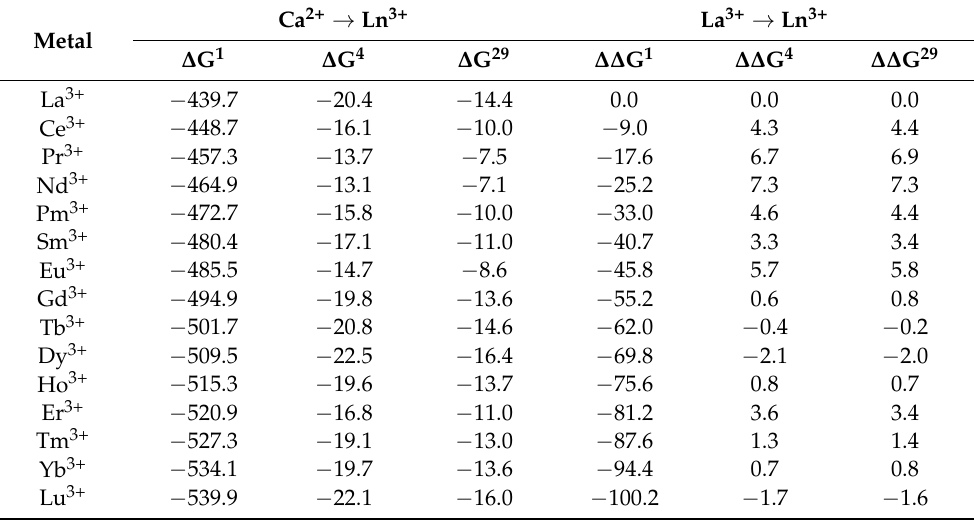
Table 2. Free energies of the Ca 2+ → Ln 3+ and La 3+ → Ln 3+ exchange (in kcal mol − 1 ) for Site 2.